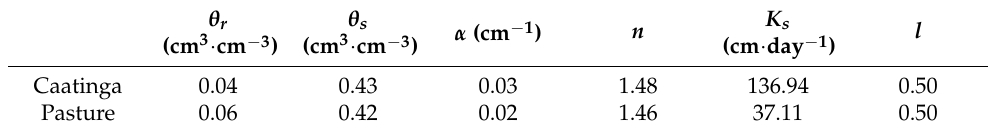
Table 2. Average VGM soil hydraulic parameters for both areas estimated by the Rosetta Lite program. θ r